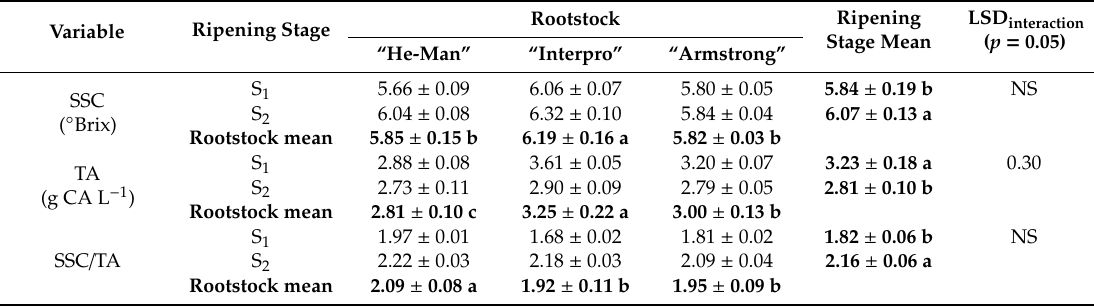
Table 3. Soluble solid content (SSC), titratable acidity (TA) and their ratio in tomatoes “Sir Elyan” as a ff ected by rootstock and ripening stage (mean ± standard error). Di ff erent letters among factor means (bold numbers) indicate significance at Fisher’s LSD test ( p = 0.05). NS: not